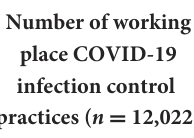
TABLE 2 Implemented COVID-19 infection control practices in the working